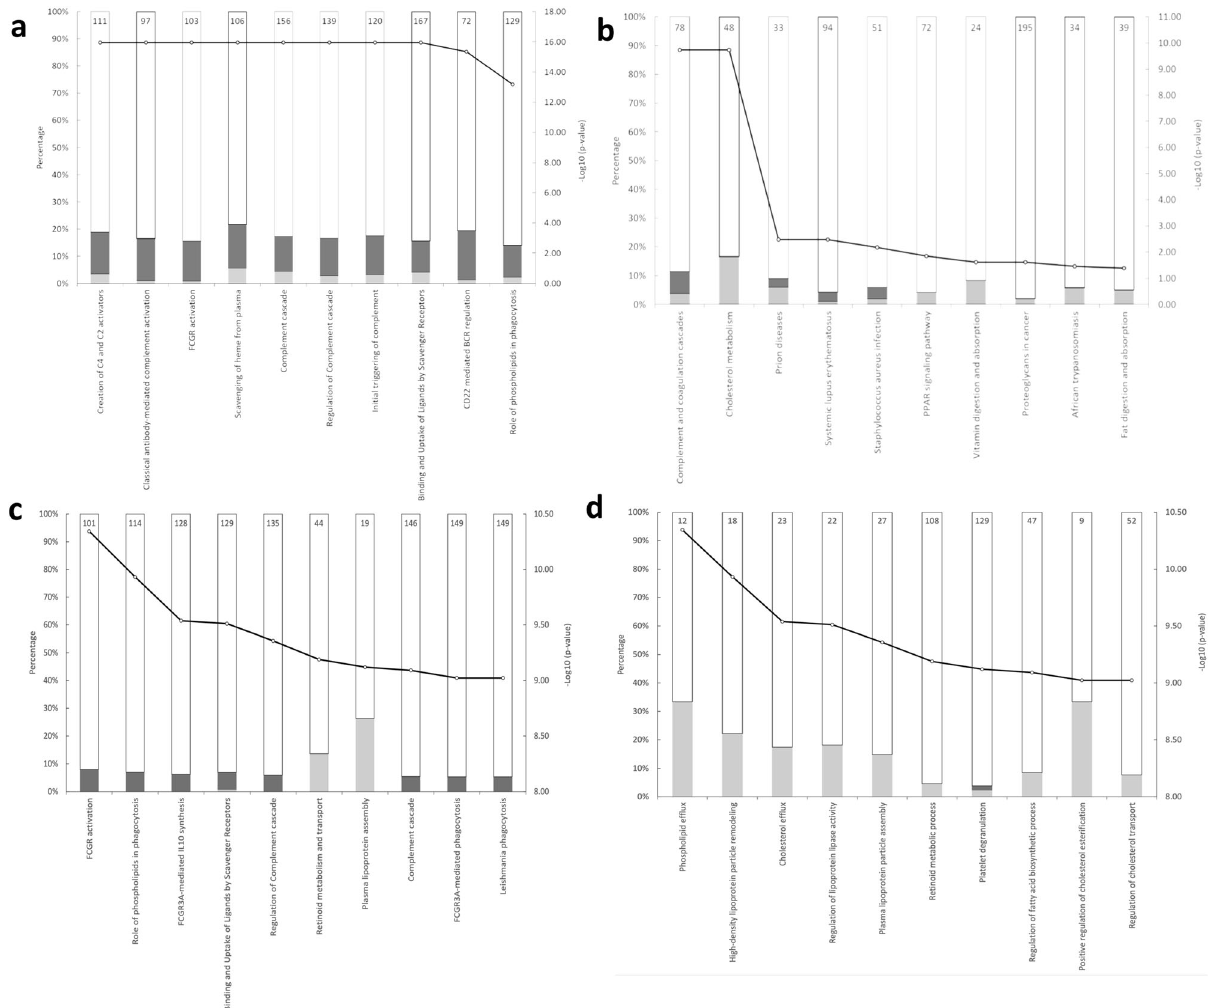
Fig. 4 Enriched pathways between MIS-C and Healthy Group. Top ten enriched pathways for the 85 differentially expressed proteins based on the unadjusted p value and fold change comparison between MIS-C Group and Healthy Group, ranked in increasing order of their p values (determined using two-sided t test) from left-to-right. ( a Reactome pathway analysis; b STRING pathway analysis). Top 10 enriched pathways for the 26 differentially expressed proteins based on the adjusted p value (using two-sided t test adjusted for multiple comparisons with Benjamini-Hochberg correction) comparison between MIS-C Group and Healthy Group, ranked in increasing order of their p values from left to right. ( c Reactome pathway analysis; d STRING pathway analysis). The size of the bar in each graph indicates the proportion of proteins in that pathway that are up- or down-regulated in our study, the number reported at the top of each bar is the speci fi c number of proteins in that pathway affected. Light grey: proteins with relative decreased expression in MIS-C Group; Dark grey: proteins with relative increased expression in MIS-C Group; Black line with a white circle: -Log10 ( p value); Number in each column represents the total proteins number of the pathway. Indicated pathways suggest biological pathways that are most impacted as a result of COVID-19